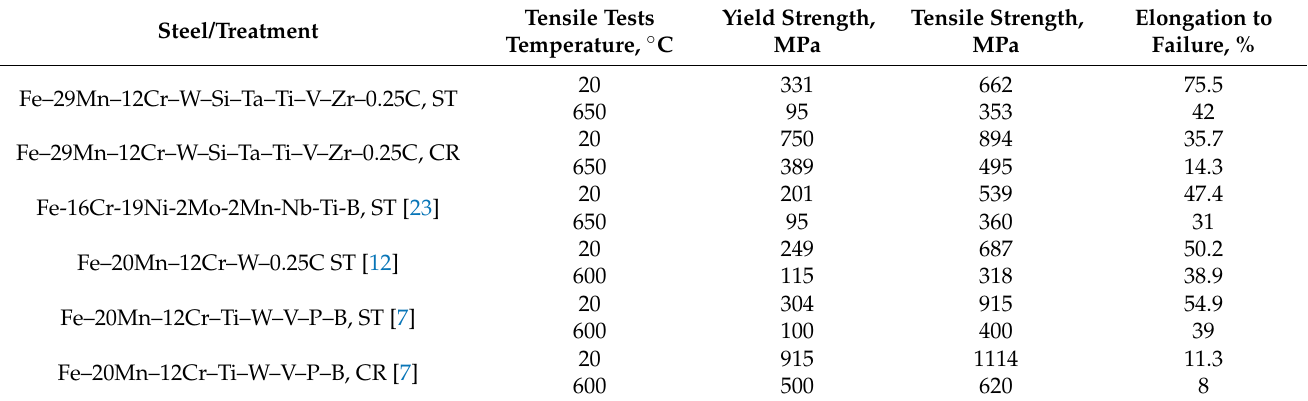
Table 2. Mechanical Properties of